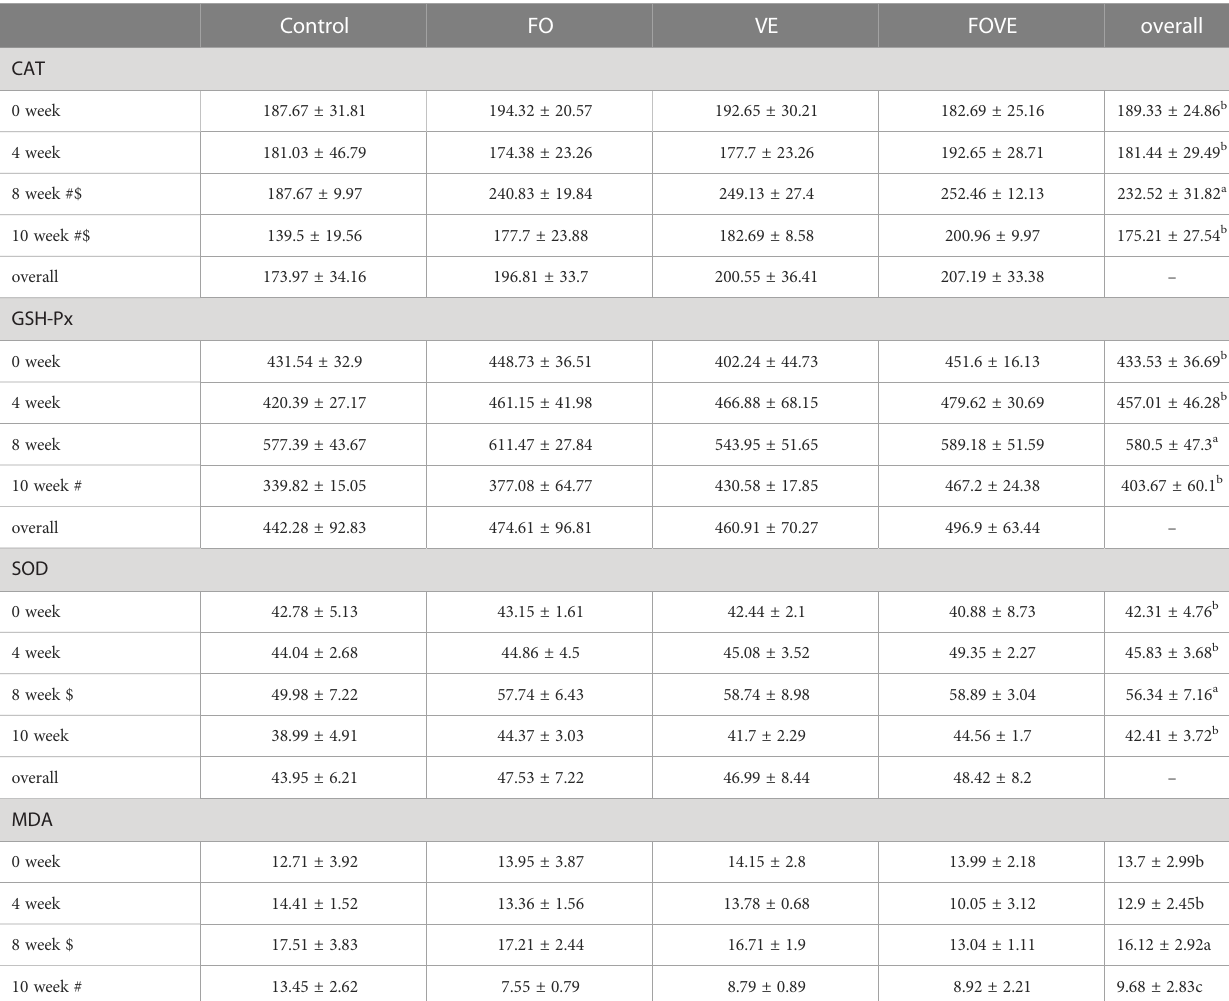
TABLE 4 Frozen-thawed semen plasma antioxidant status and